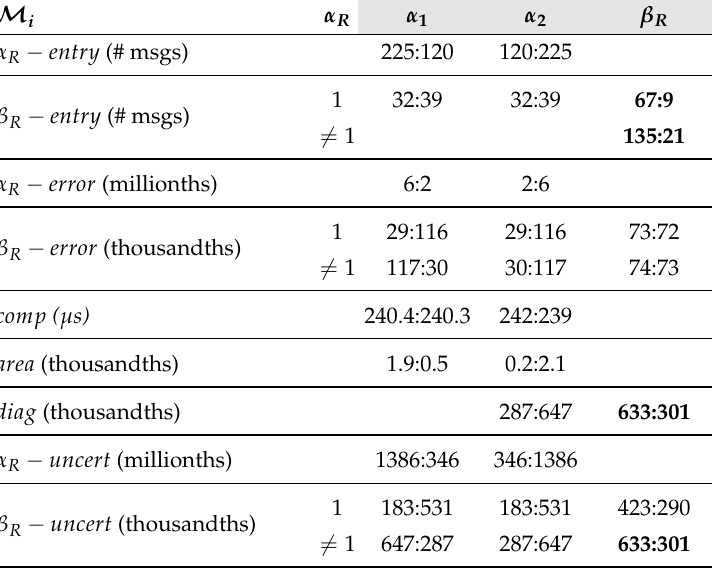
Table 3. Effects of the scenario on clock synchronization—clocks. Bold values are very relevant, as explained in the main